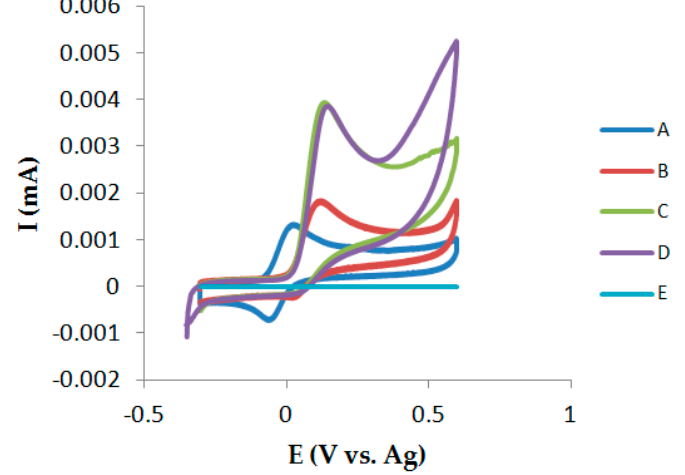
Figure 9. Cyclic voltammetry of DOPA (2.5 × 10 − 5 M) as a function of GSH addition. ( A ) DOPA (2.5 × 10 − 5 M). ( B ) In the presence of 5 × 10 − 5 M GSH. ( C ) In the presence of 1.24 × 10 − 5 M GSH. ( D ) In the presence of 2.5 × 10 − 4 M GSH. ( E ) GSH (5 × 10 − 5 M).